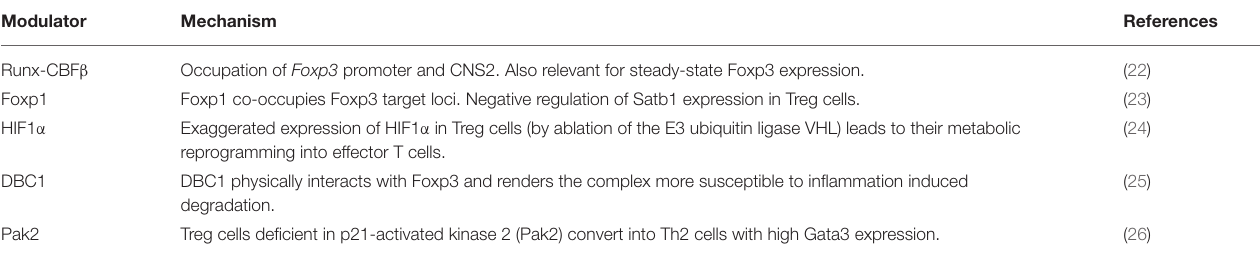
TABLE 1 | Selection of molecules directly involved in the transcriptional regulation of Foxp3 in murine NLT Treg cells.